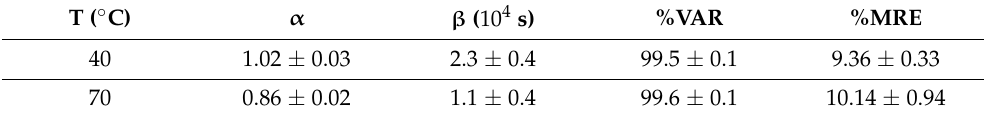
Figure 1. Experimental drying kinetics of porcine liver at 40 ◦ C ( A ) and 70 ◦ C ( B ) and the same drying kinetics calculated using the Weibull model. Table 1. Weibull model parameters for porcine liver dried at 40 ◦ C and 70 ◦